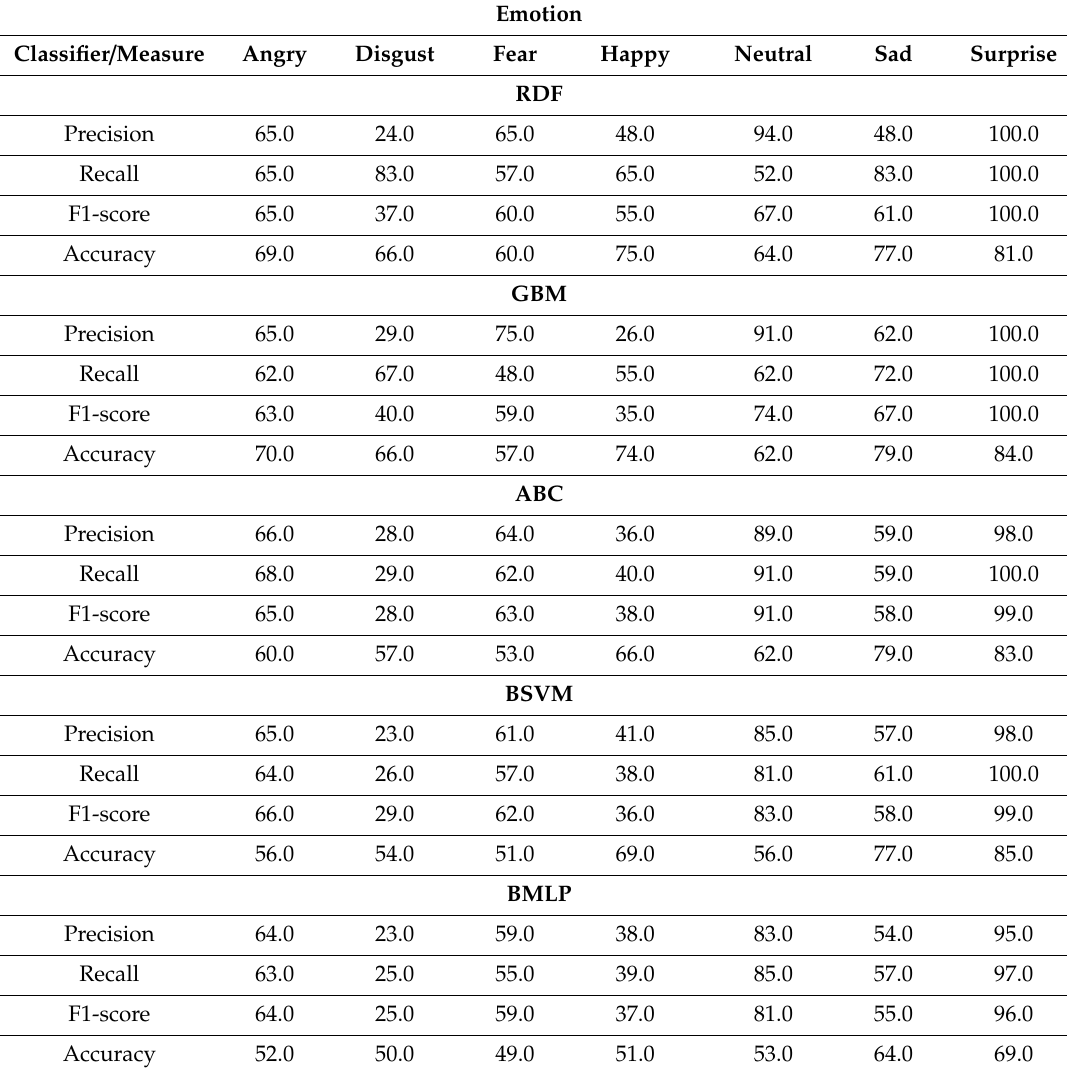
Table 8. Percentage precision, recall and F1-score and accuracy on SAVEE